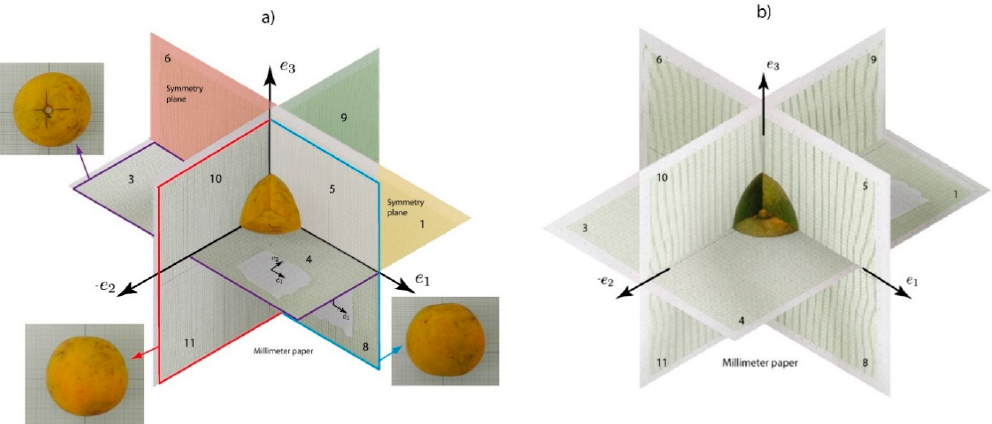
Figure 5. Image intersection to define Bézier’s profiles. ( a ) Ripe orange and ( b ) unripe orange.